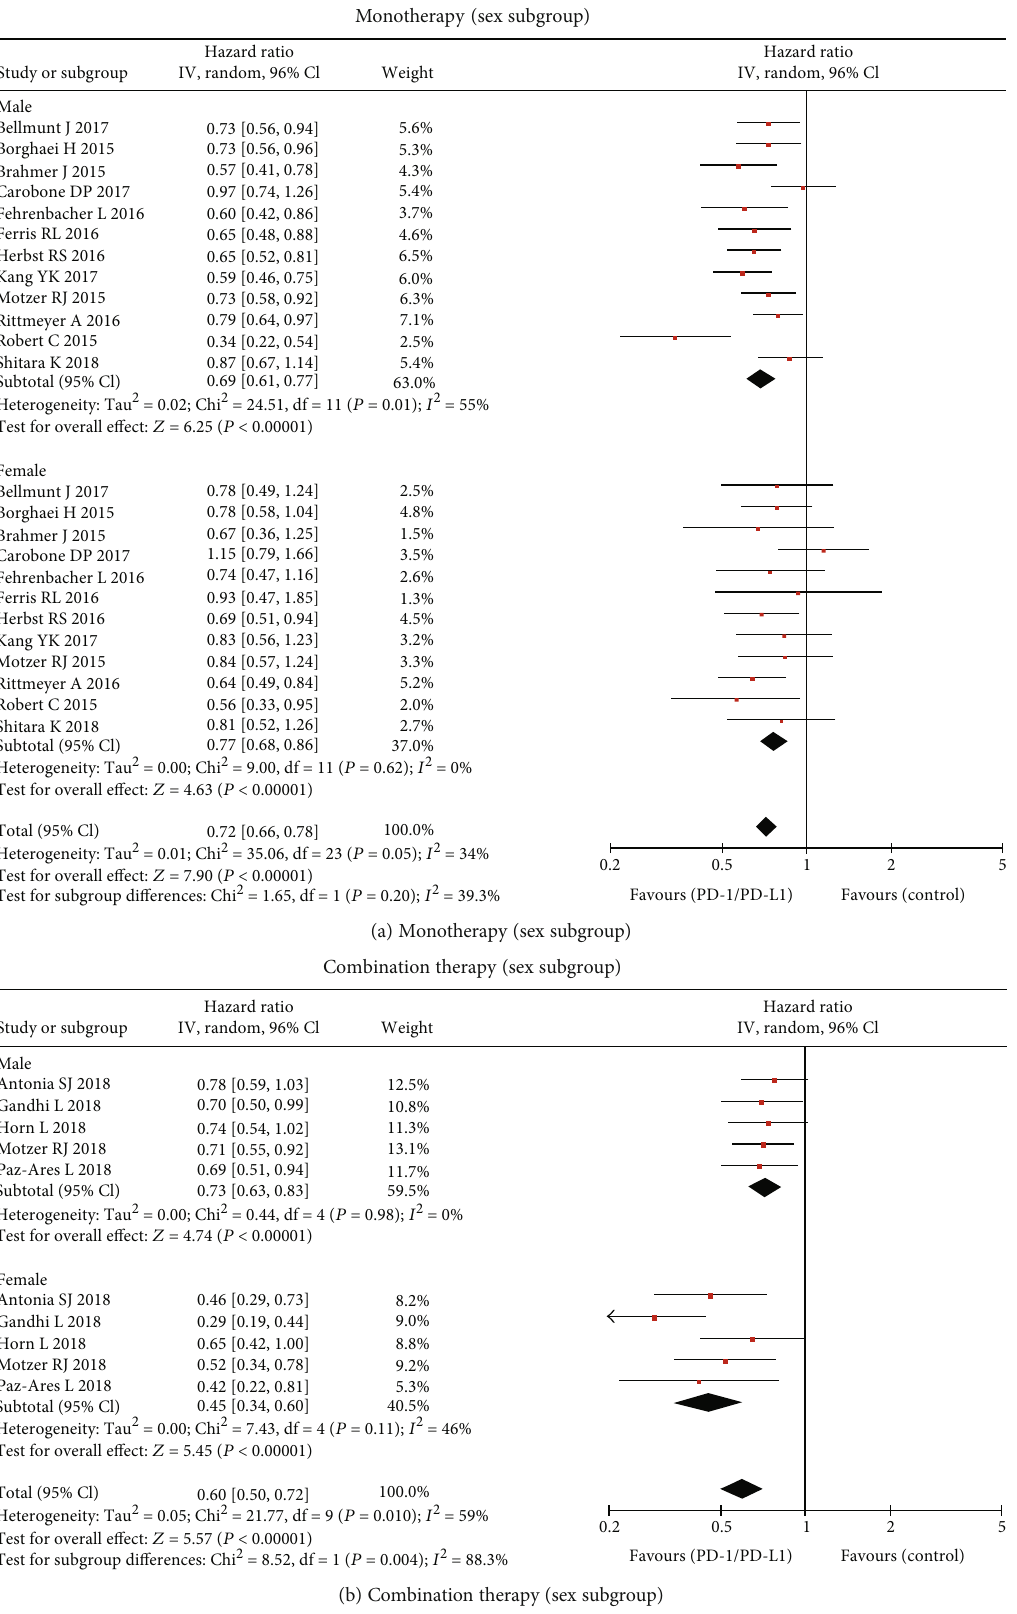
Figure 4: Forest plot of the hazard ratio comparing overall survival in patients who received PD-1/PD-L1 inhibitors versus control by sex: (a) monotherapy group and (b) combination therapy